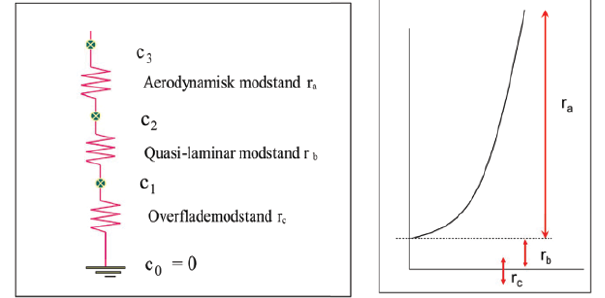
Fig. 8. Sketches illustrating the resistance method with the three re- sistances – the aerodynamic resistance, the quasi-laminar sub-layer resistance, and the surface resistance. The concentration at the sur- face is here assumed to be